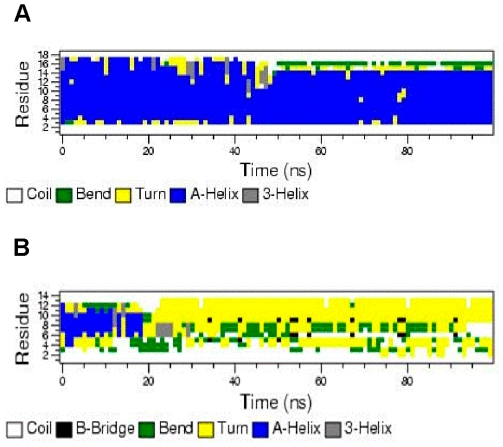
DSSP plot of secondary structure of D-4F (A) and OxP-11D (B) as a function of time in a simulated HFIP:buffer 6∶4 environment.